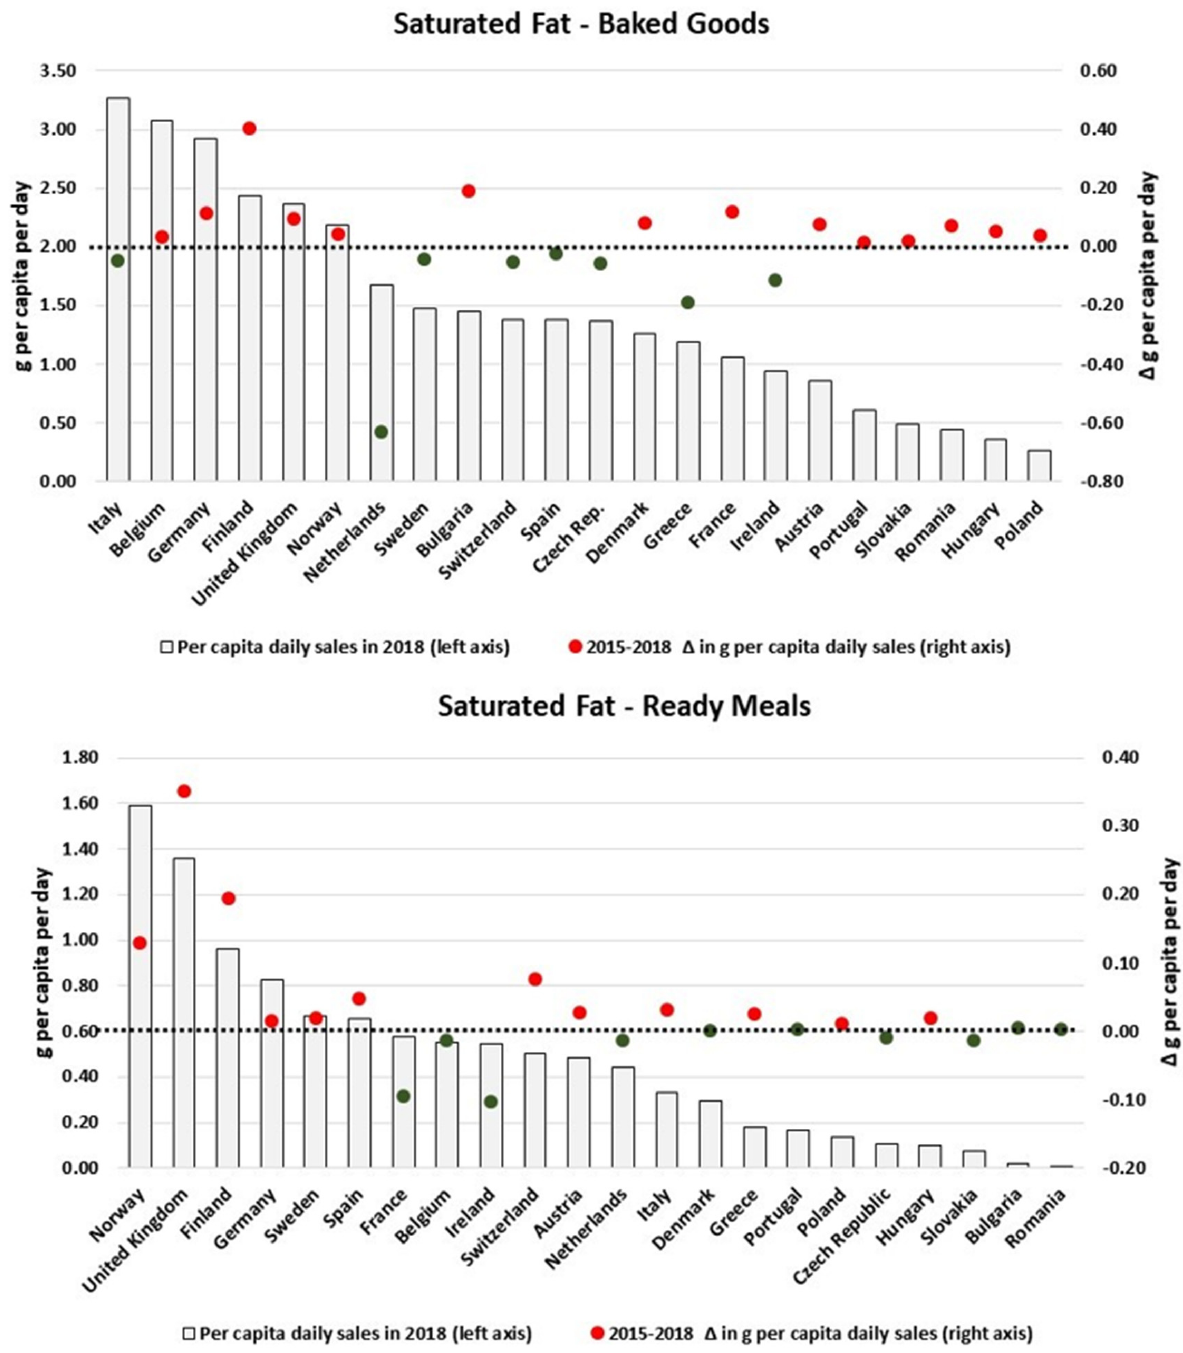
Figure 6. Estimates of saturated fat sold through Baked Goods and Ready Meals in 2018 and the respective 2015–2018 variation (in g/pc/day). Source: Elaborated by the authors based on data from Euromonitor (2020) and mid-year population estimates from the HFA-DB. Estimates were scaled by market coverage to represent 100% of the retail market. The right-hand axis represents the nutrient variation in g per capita per day (green for negative values, red for positive values), and the dotted black line indicates the variation of 0 g per capita per day as a reference.